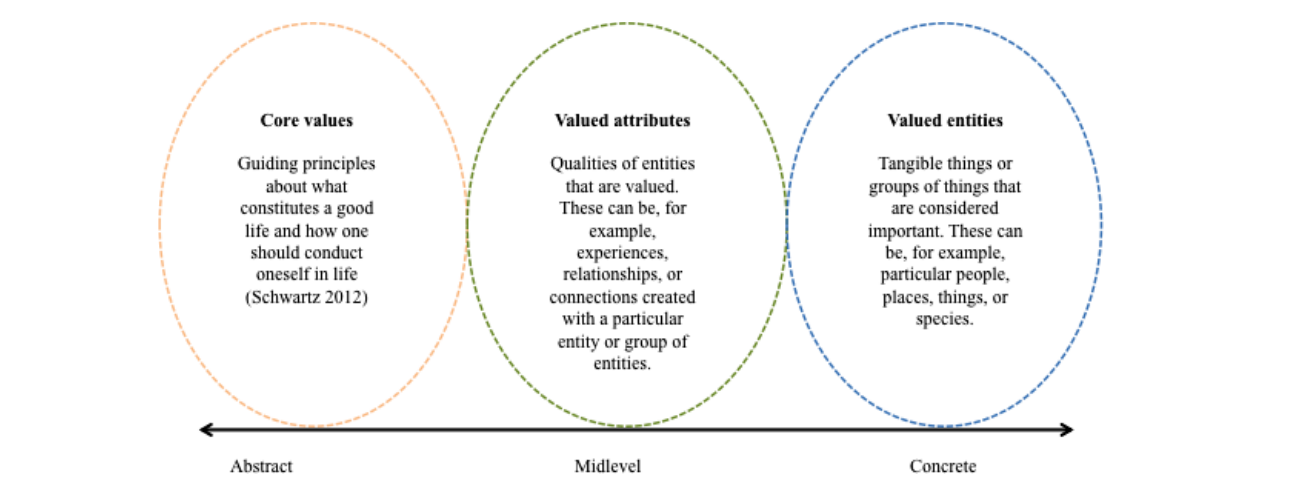
Fig. 1 . Conceptual framework of values from abstract to concrete: core values, valued attributes, and values entities. This conceptual framework, and the accompanying descriptions, is adapted from Rawluk et al.